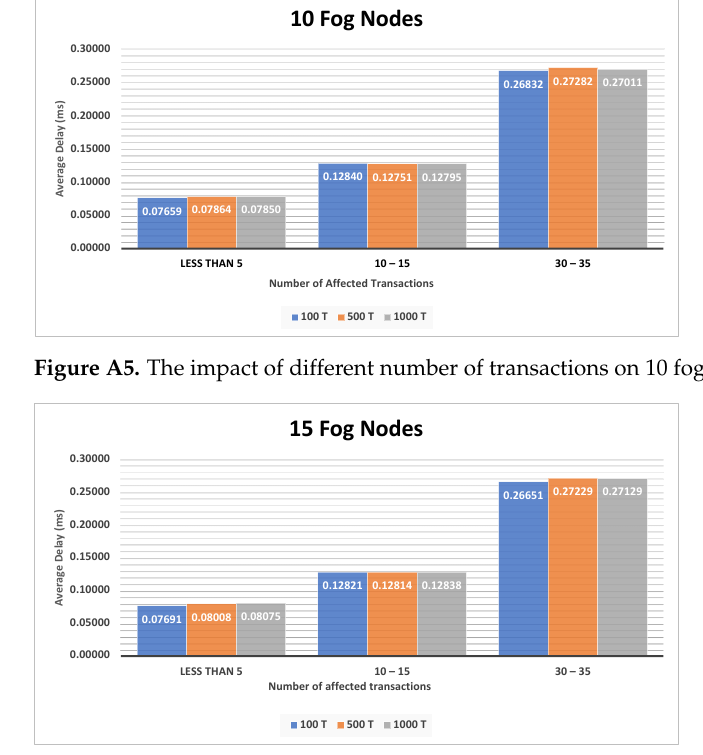
Figure A6. The impact of different number of transactions on 15 fog nodes.